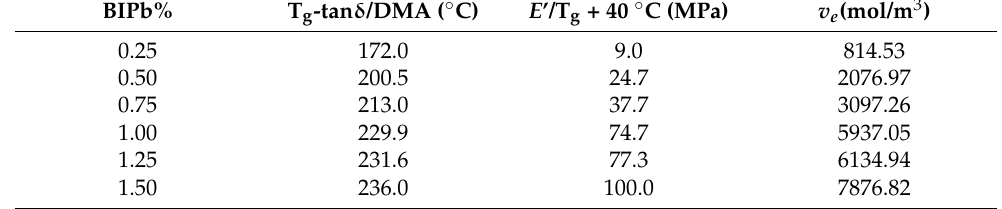
Table 5. The thermal properties of different initiator mass fraction samples.